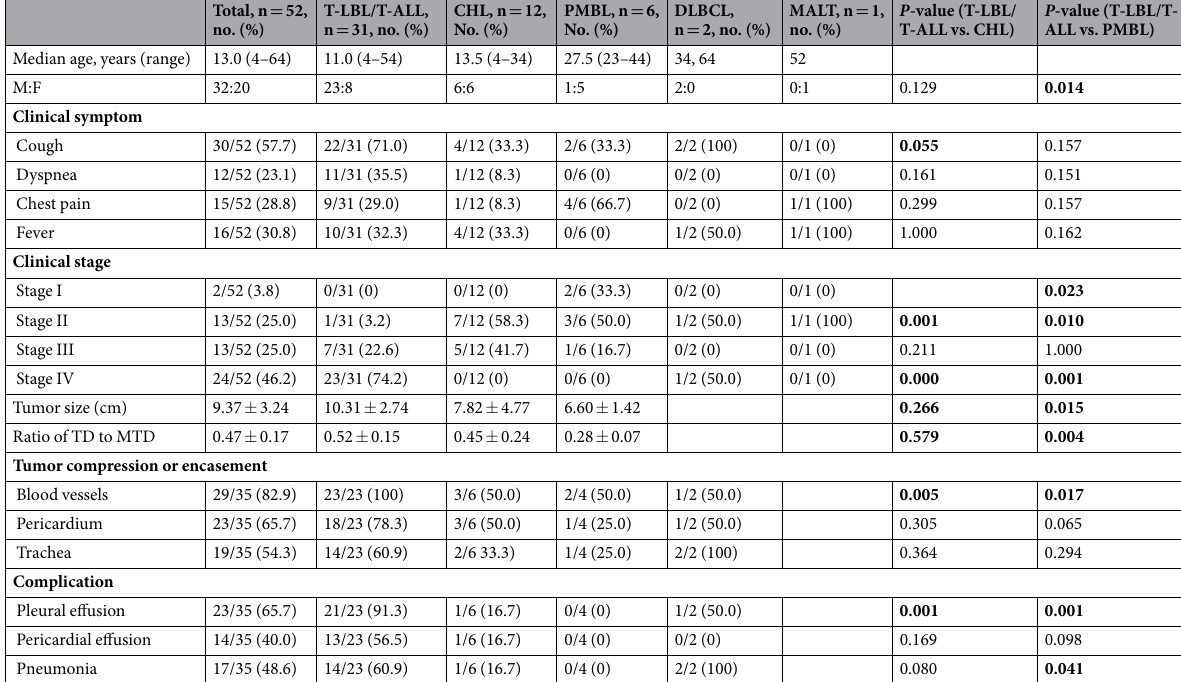
Table 3. Comparisons of clinical features, and radiographic findings among different histological